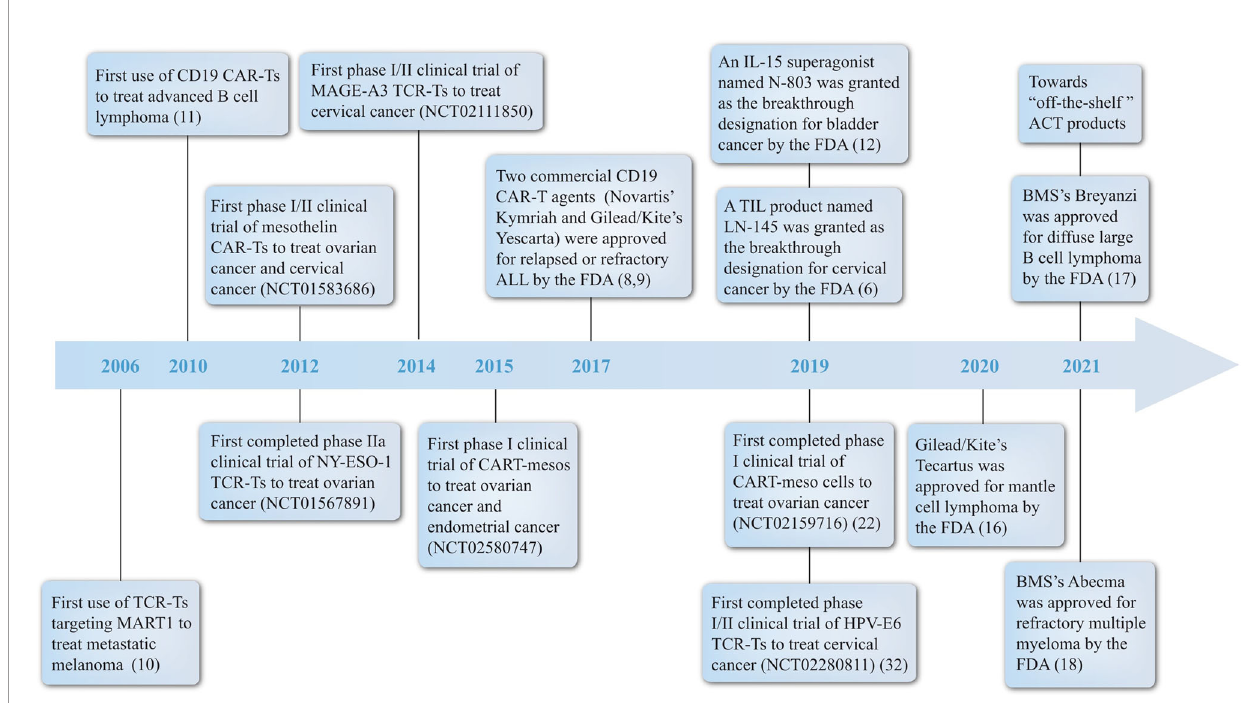
FIGURE 1 | Milestones of ACT. A brief summary of some landmark achievements in ACT development history with a focus on engineered T cells for treating gynecologic malignancies from the year 2006 to 2021. Signi fi cant events include: (1) pioneer treatment of metastatic melanoma by TCR-T and B cell lymphoma by CAR-T; (2) the fi rst or the fastest progressing clinical trial of engineered T cells in different gynecologic tumors; (3) the acknowledgement of CAR-T, TIL and IL-15 products by FDA. ACT, adoptive T cell therapy; BMS, Bristol-Myers Squibb; CAR, chimeric antigen receptor; FDA, the Food and Drug Administration; IL, interleukin; TCR, T cell receptor; TIL, tumor in fi ltrating